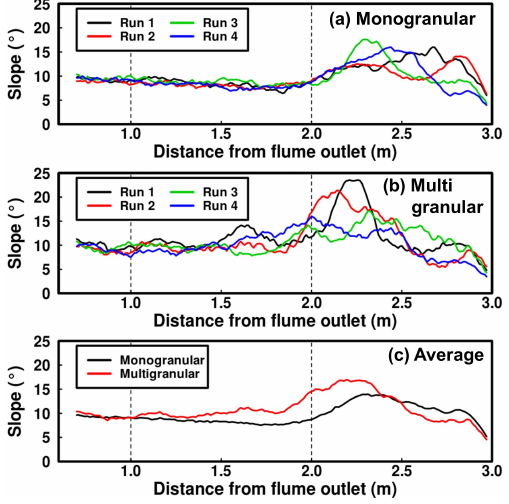
Figure 16. Slopes along the center of the final fans. The slope val- ues were averaged over 0.2m intervals. The upper, middle, and lower panels indicate monogranular flows, multigranular flows, and their averages, respectively. Vertical broken lines indicate the boundaries of bed slope (i.e., the change points from 12 to 9 ◦ and from 9 to 6 ◦